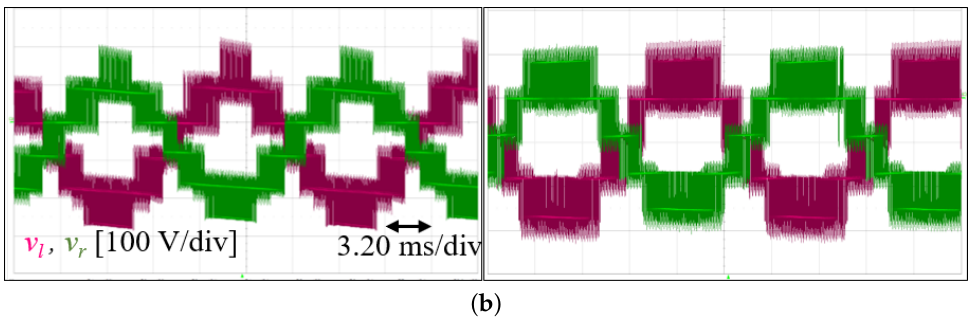
Figure 13. Experimental result of converter arms’ current ( a ), and voltage with: 60 V DC offset and 100 V DC offset (left and right, respectively) ( b ).